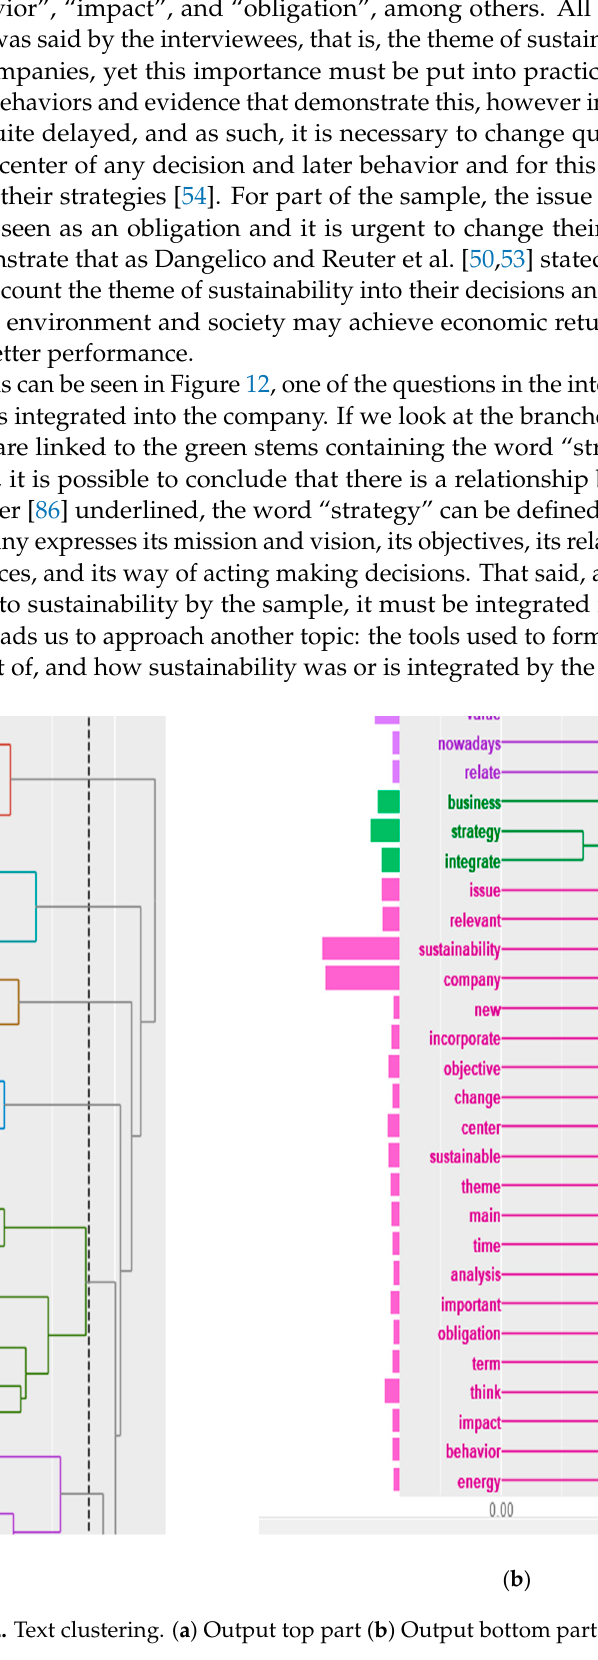
Figure 12. Text clustering. ( a ) Output top part ( b ) Output bottom part